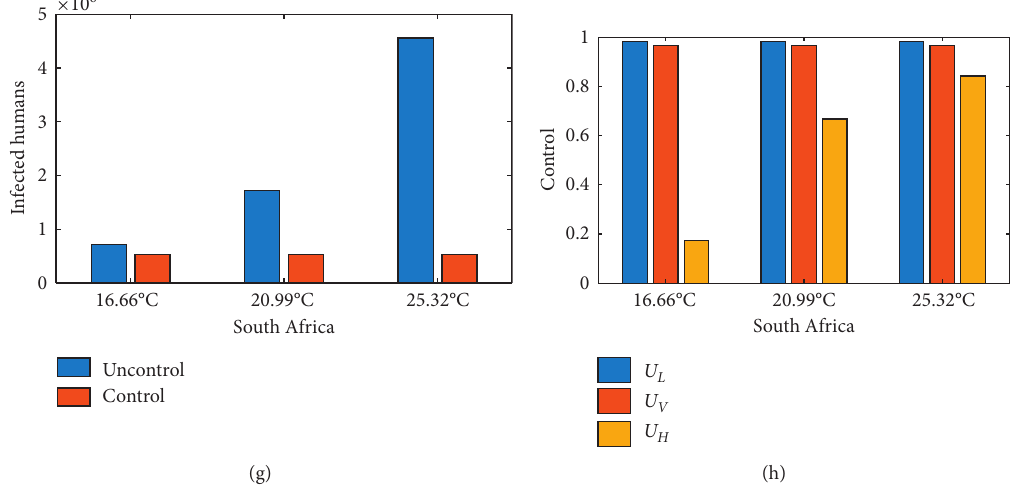
Figure 14: Simulations of the malaria-resistant model (21) as a function of time: (a, c, e, g) the monthly total number of infected humans with control and (b, d, f, h) optimal controls u H ( t ) , u L ( t ) , and u V ( t ) , in West, Central, East, and South Africa.